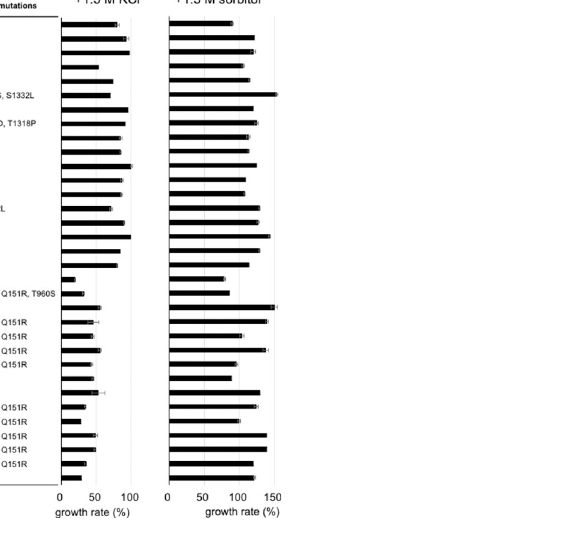
Fig 2. Mutations in the NikA proteins and resistance to high osmotic pressure in P . chrysogenum and P . oxalicum . The list of mutations in the NikA proteins (left) and colony growth rates in the presence of a high concentration of KCl (middle) and sorbitol (right). The data represent the averages of triplicate individual experiments (means ± standard deviations).